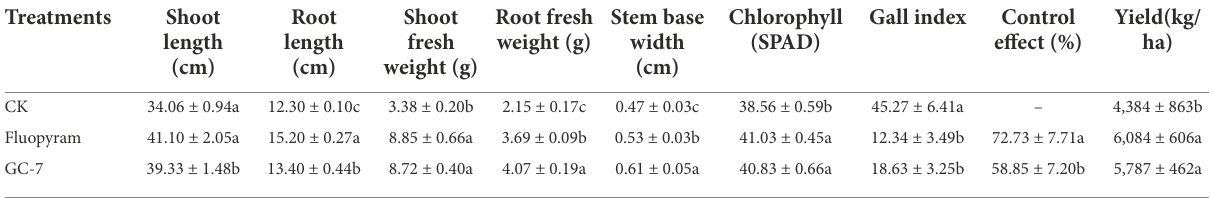
TABLE 3 Effects of biocontrol agents (isolate GC-7) on the growth parameters and protection of rice plants infected with M. graminicola under natural field conditions in 2021.